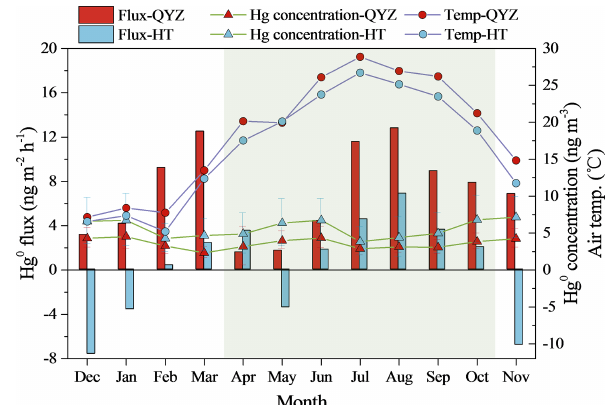
Figure 5. Monthly variations of GEM flux, GEM concentration and air temperature at sites QYZ and HT. The leaf-growing season is marked as the shaded